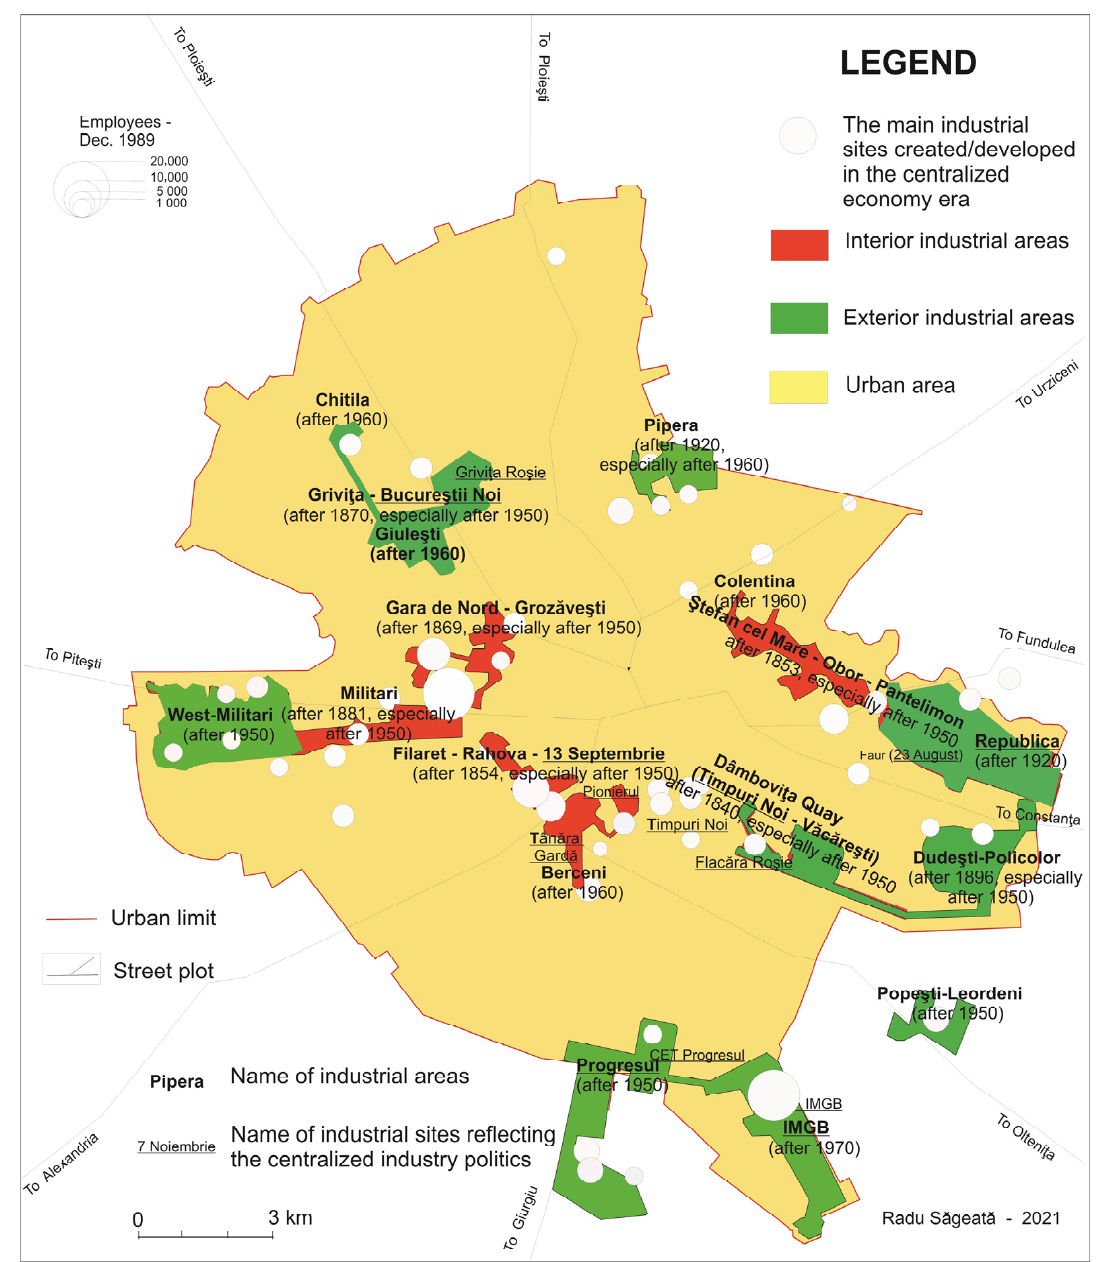
Figure 1. The centralized industrialization of Bucharest.